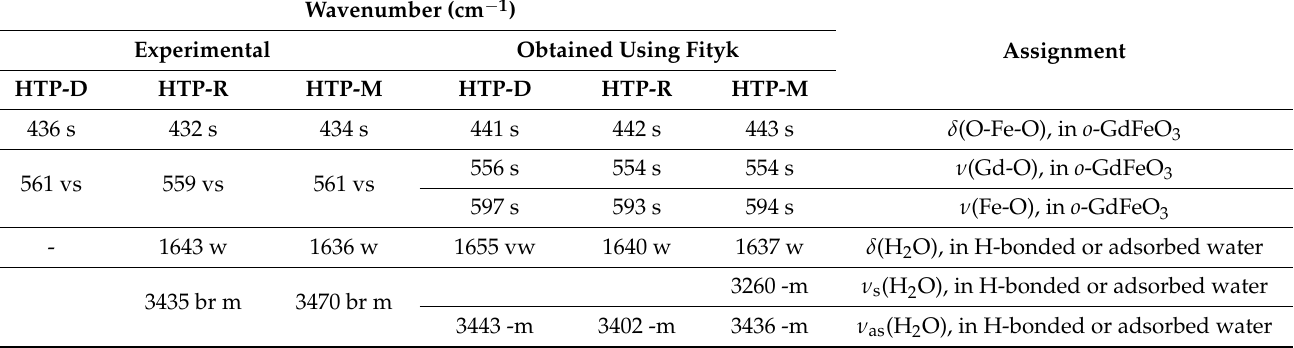
Table 2. Assignment of bands in the FTIR spectra of the heat-treated